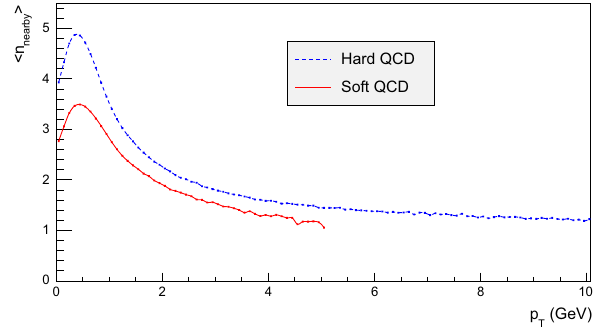
Fig. 28 Average number of overlapping hadrons as a function of the p ⊥ of the hadron studied. The red and blue distributions illustrate the soft and hard QCD processes, where the former stops at 5 GeV owing to limited statistics at large p